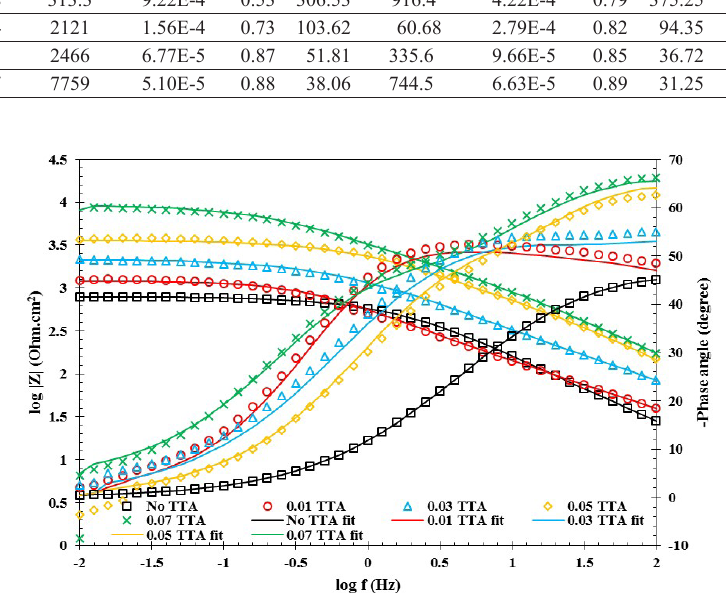
Figure 8. Bode plots for the corrosion of mild steel in 0.5 M HCl solution with various concentrations of TTA (0.01 to 0.07 M) at 293 K.